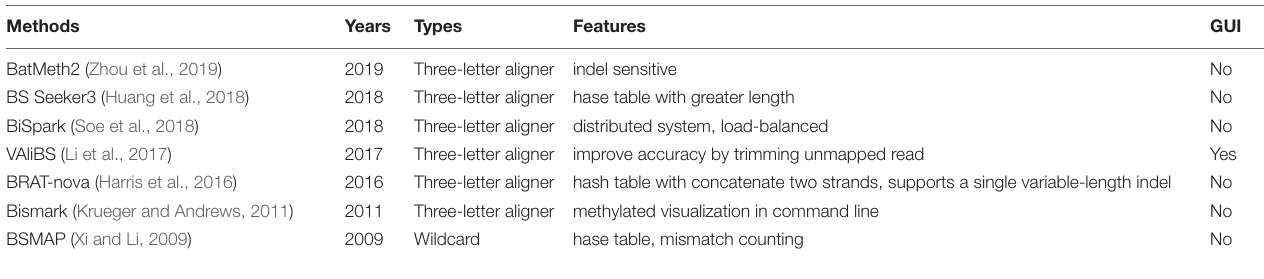
TABLE 1 | Aligners for bisulfite sequencing